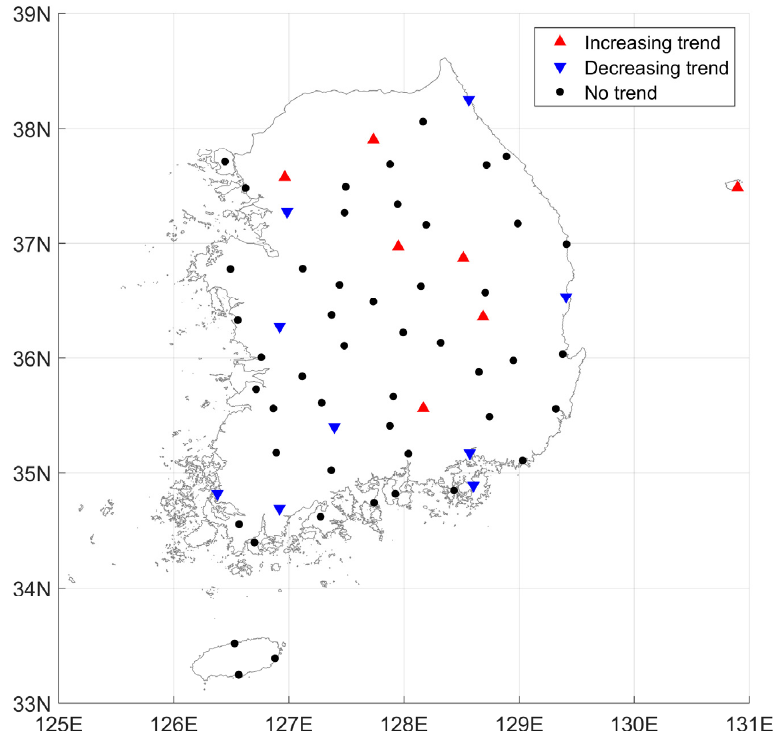
Figure 7. The trend test results of scaling exponent estimate series for the subsample sets of the AM series on the annual basis. Note that subsample sets are extracted by the 20-year moving window from the whole AM series and the significant levels of the employed trend tests are